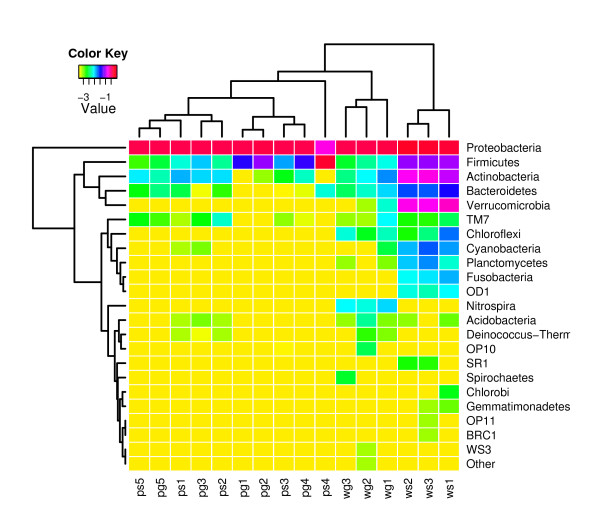
Hierarchical clustering of samples using phylum level distributions. Employing an alternative Qiime-based methodology to analyze our sequences, we see that water samples consistently cluster within their own specific environments. Again, this is not so for the fruit surface samples. Displayed values are log transformed relative abundances within each sample, (e.g. 0.10 ~-1; 0.01 ~-2). Visualized using skiff in CloVR.